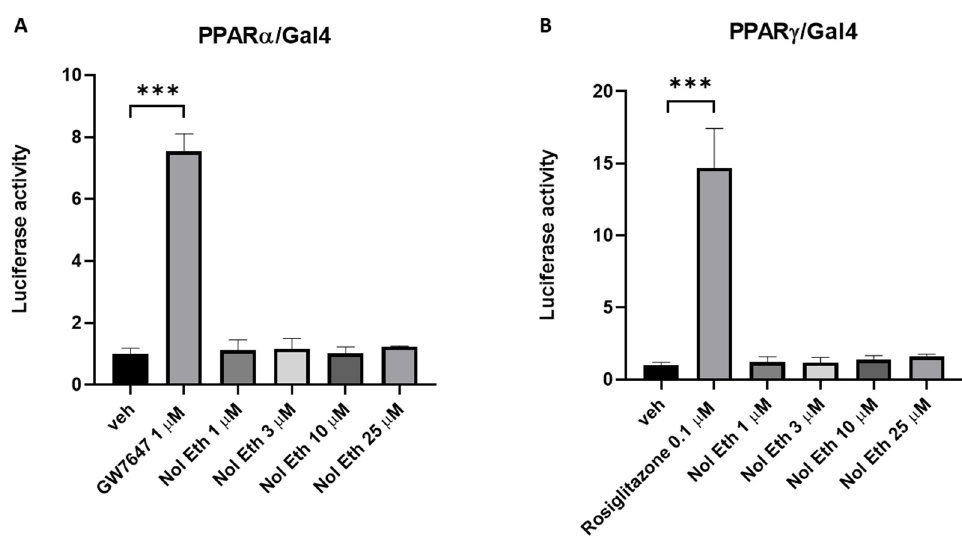
Figure 5. Effect of noladin ether (Nol Eth) in PPAR α - or PPAR γ reporter cell lines. Luciferase assay was performed in HEK293 cells transiently expressing the ligand-binding domain (LBD) of human PPAR α ( A ) and/or PPAR γ ( B ) fused to the yeast GAL4 DNA binding domain (DBD). Bar graphs showing the ratio between the firefly and Renilla luciferase in response to increasing concentrations of noladin ether. GW7647 (1 μ M) and rosiglitazone (0.1 μ M) were used as positive controls for PPAR α ( A ) and PPAR γ ( B ), respectively. The vehicle group value was set to 1. Each point is the mean ± SEM of four separate determinations performed in duplicate. *** p ≤ 0.0005 versus the vehicle (dimethyl sulfoxide, DMSO) group.